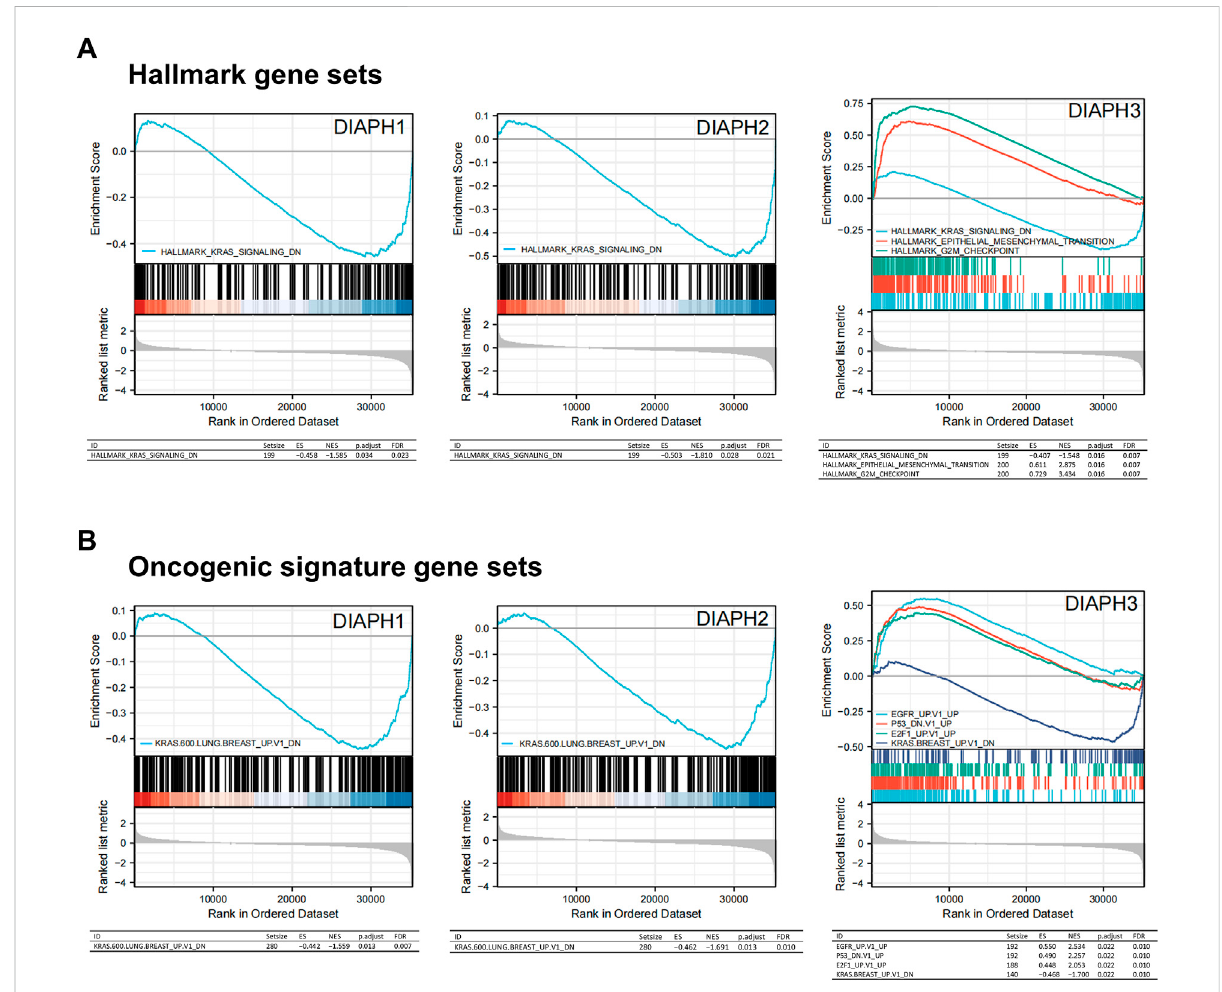
FIGURE 7 Gene set enrichment analysis of DIAPHs. (A) Hallmark gene sets in DIAPHs expression groups. (B) Oncogenic signature gene sets in DIAPHs expression groups. ES, enrichment score; NES, normalized enrichment score; FDR, false discovery